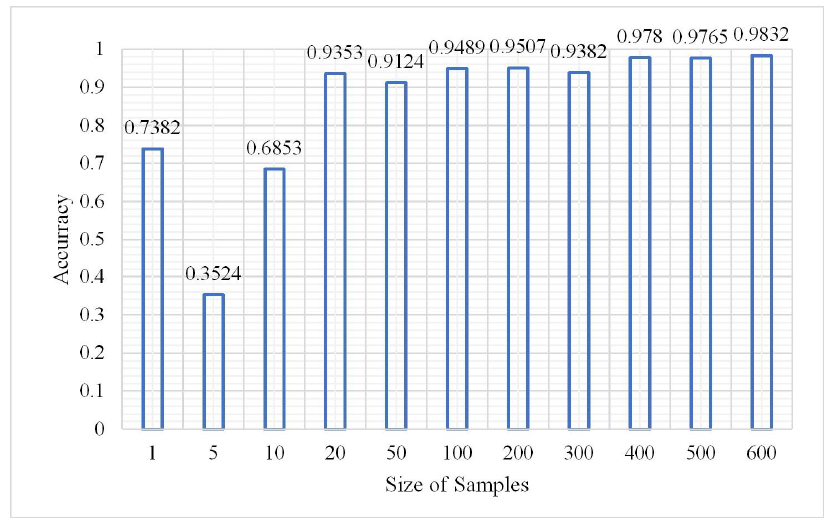
Figure 20. Change in overall accuracy.